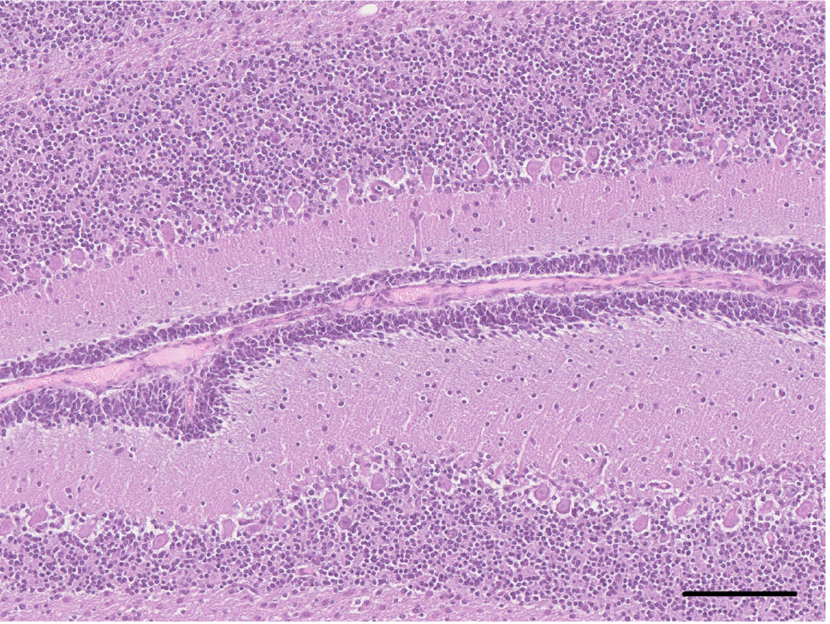
Figure 7. Cerebellum of dog 2. There is the presence of numerous immature neurons in the external granular layer of the cerebellar cortex (HE, bar = 125 μ m).